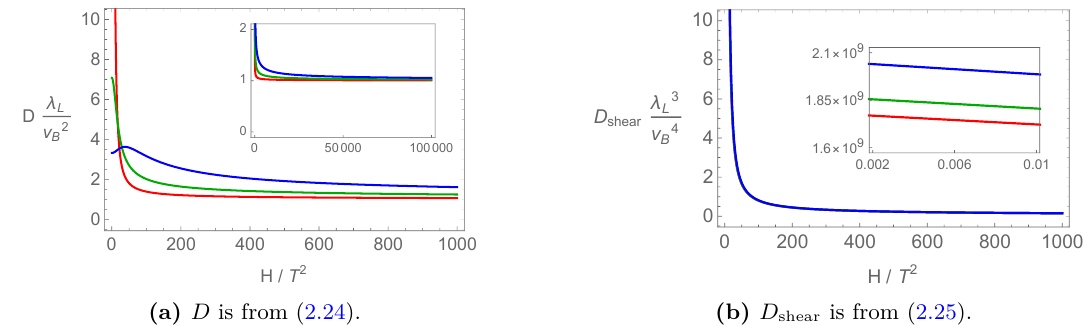
Figure 4. Diffusion bounds at µ/T = (0 , 3 , 5) (red, green, blue). The diffusion constant D can have the lower bound (3.17) at H/T 2 (cid:29) 1 , while the subdiffusive constant D shear does